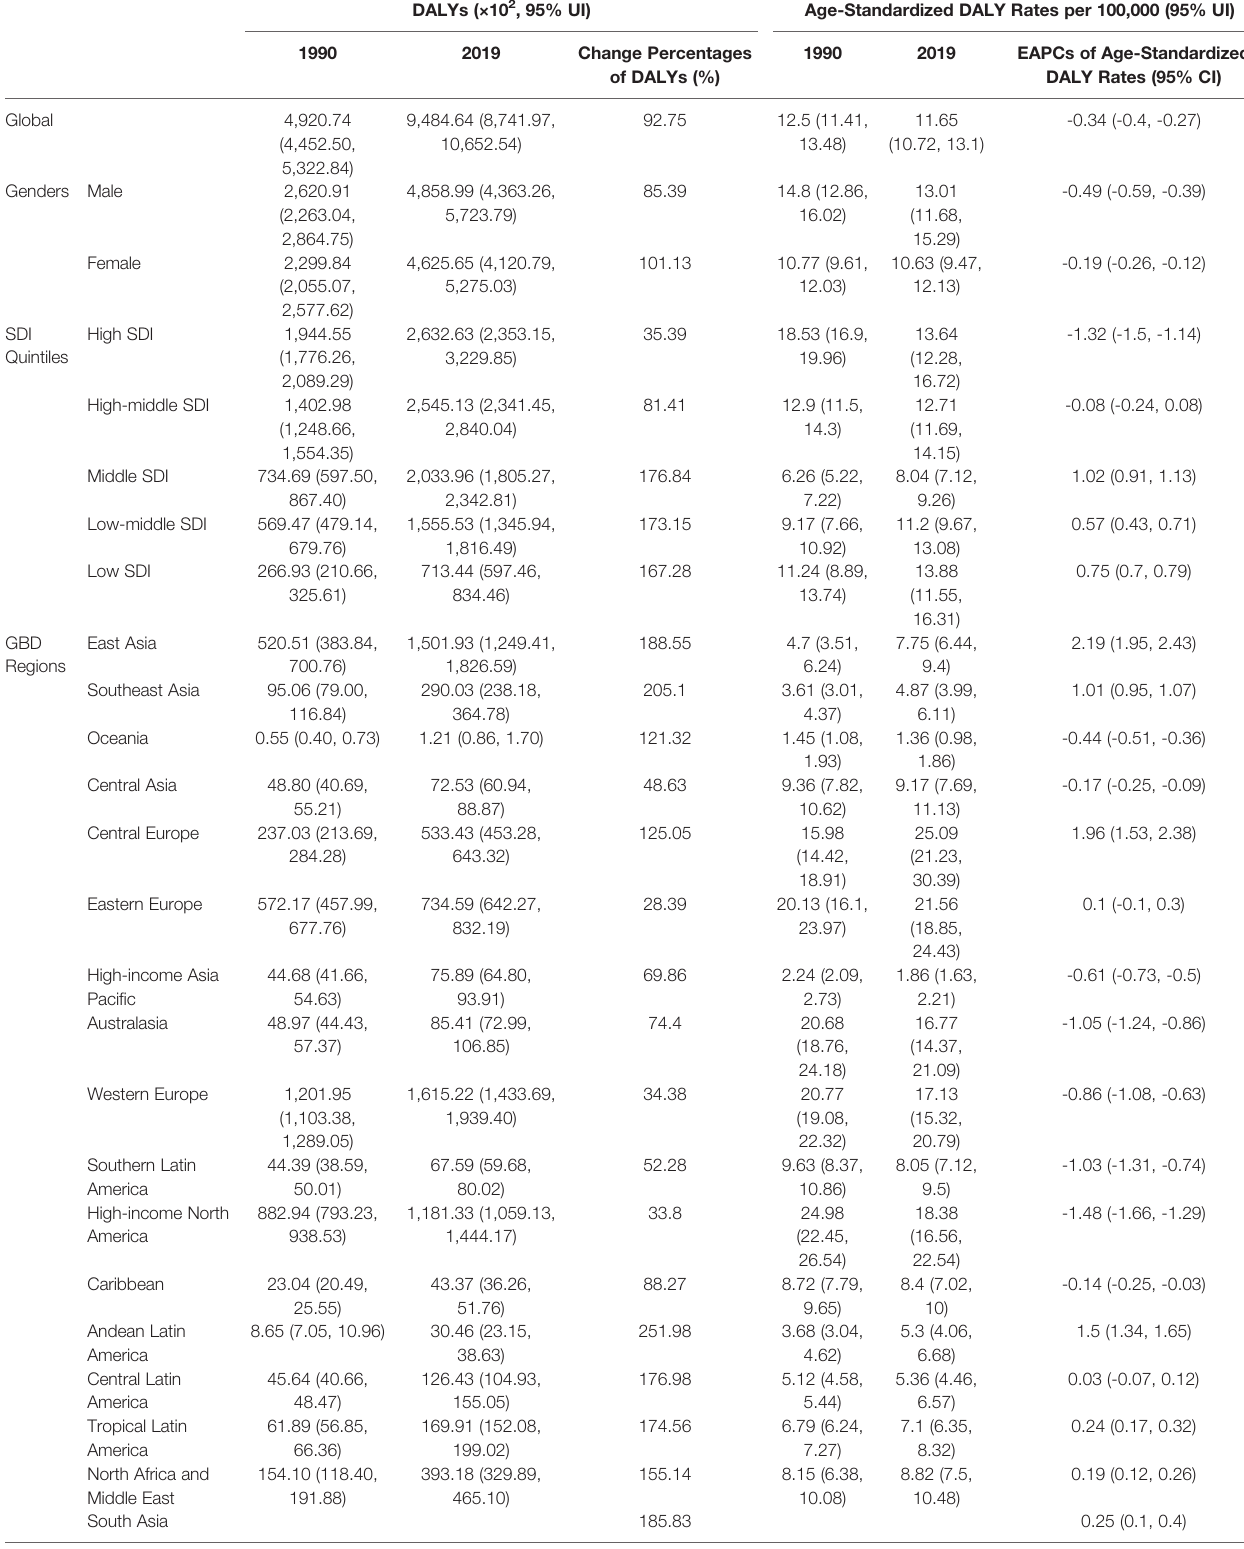
TABLE 3 | The DALYs and age-standardized DALY Rates of CLL in 1990 and 2013, and the trends from 1990 to